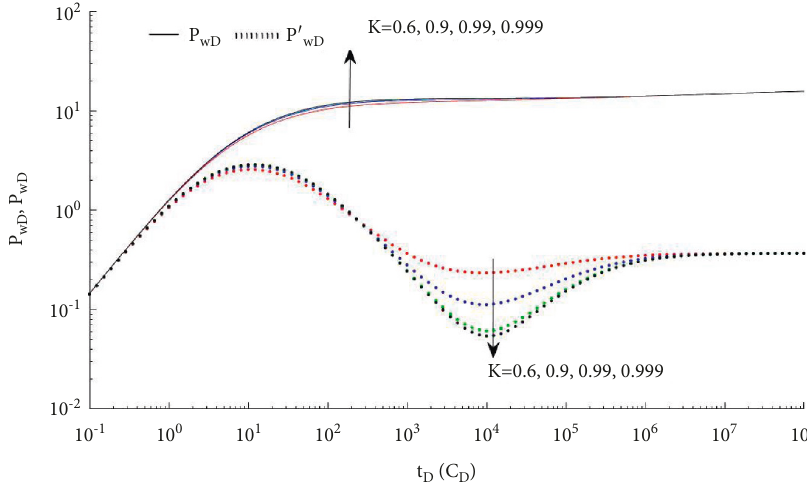
Figure 6: Dimensionless pressure of vertical wells under the infinite outer boundary influenced by K ( C